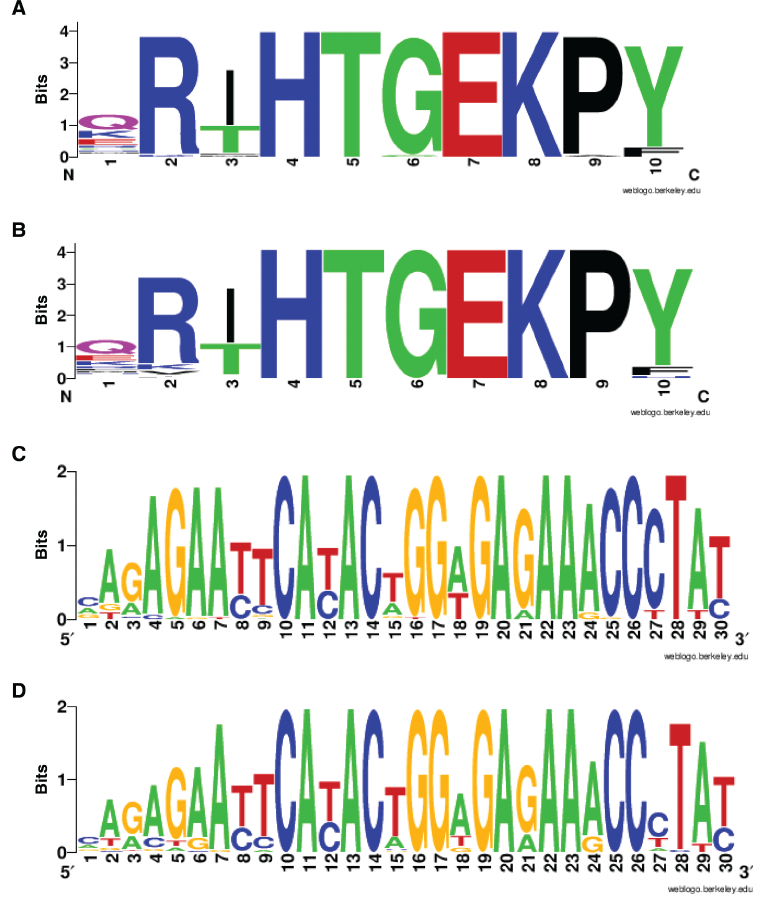
Figure 4: Comparison of the sequence motifs in adjacent repeated protein regions. The amino acid and DNA sequences of the 44 selected motifs associated with SUMO binding (A and C), are compared to the equivalent motifs on the same proteins/genes, in the immediate N-terminal or C-terminal regions (B and D). These motifs have similar amino acid sequences (chosen by using the template HT[GC]EK[AP]) to retrieve sequences immedi- ately before or after the selected sites). The four sequence logos were generated using WebLogo [15].